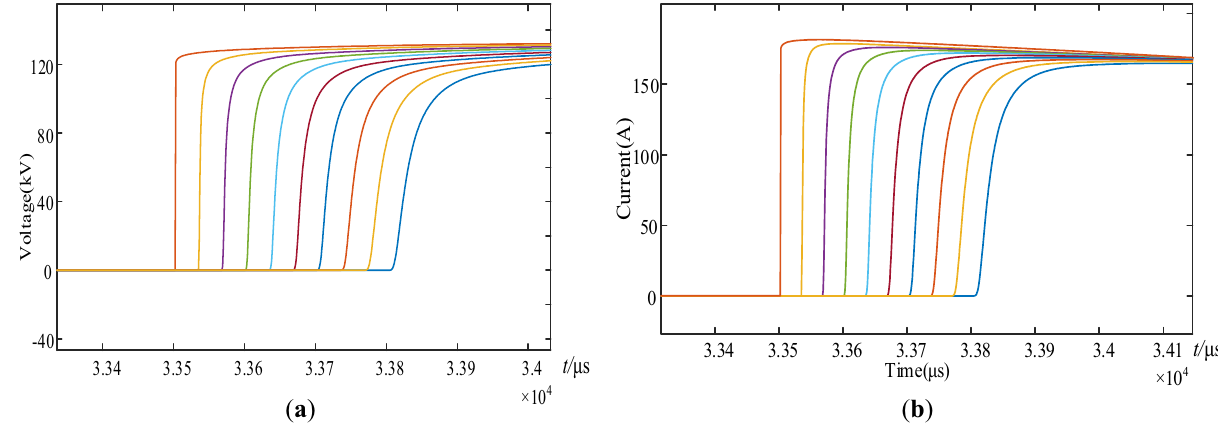
Figure 5. ( a ) Initial traveling wave waveform of voltage at each measuring point; ( b ) Initial traveling wave waveform of current at each measuring point.